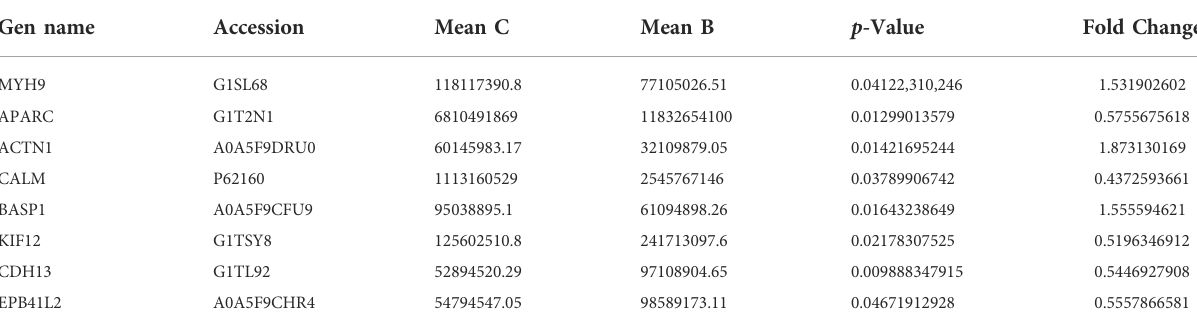
TABLE 4 Differential expressed